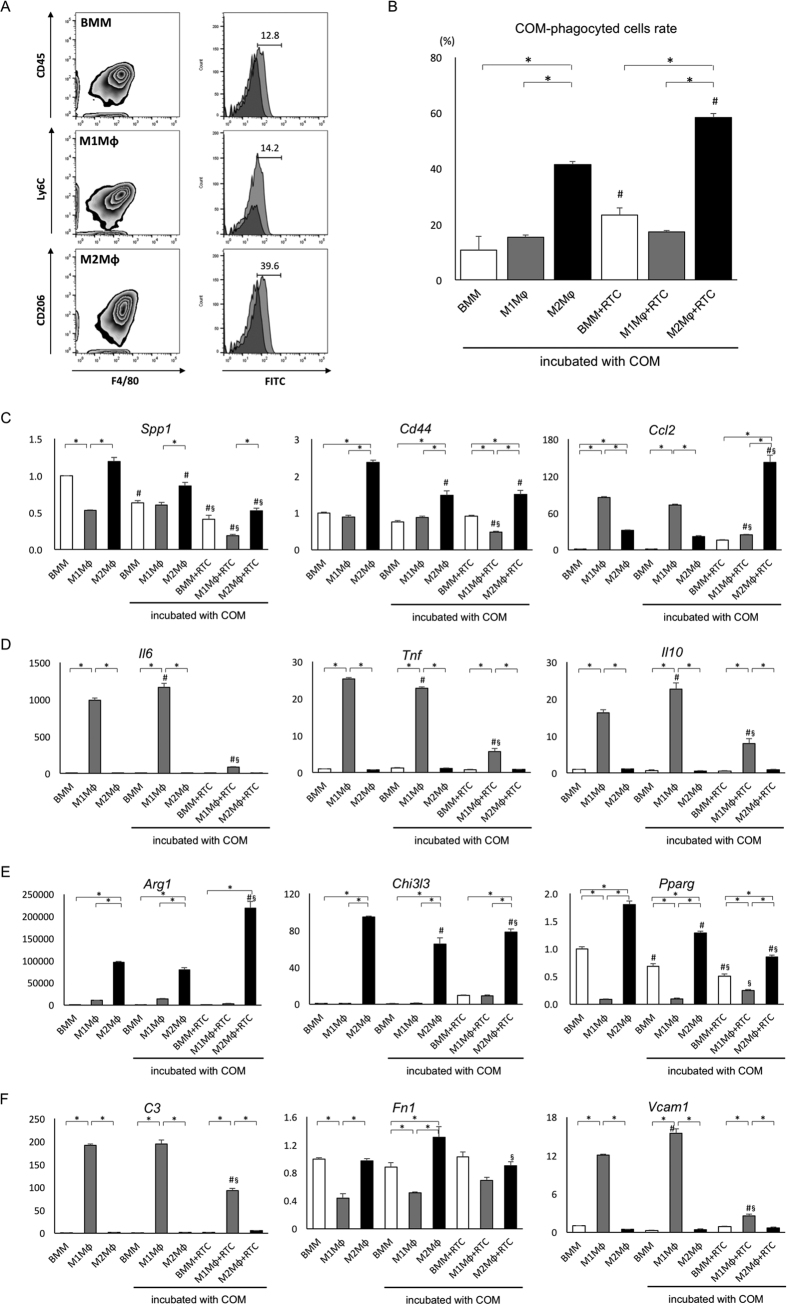
Analysis of the ability of M1 and M2 macrophages to phagocytize calcium oxalate (CaOx) monohydrate (COM) crystals in vitro.(A) Schematic representation using flow cytometry. Detection of bone marrow-derived macrophages (upper), M1 macrophages (middle), and M2 macrophages (bottom) with fluorescein isothiocyanate (FITC) -labeled COMs phagocytized by each macrophage type (right). (B) Quantitative analysis of phagocytic macrophages. The ratios of COM phagocytic macrophages were evaluated by flow cytometry. Data are presented as means ± standard errors. N = 6 for each group. *Indicates significant differences among three different macrophages at p < 0.05; #indicates significant differences in the mono-culture of each macrophage group at p < 0.05. (C) Expression of crystal-related genes. (D) Expression of M1 macrophage-related genes. (E) Expression of M2 macrophage-related genes. (F) Expression of adherence-related genes. The expression of each gene was determined by quantitative reverse transcription polymerase chain reaction (qRT-PCR) using TaqMan assays. Control values are the average of the data for bone marrow-derived Mφs (BMMs) without COM incubation group. Data are presented as means ± standard errors. N = 6 for each group. *Indicates significant differences among three different macrophages at p < 0.05; #indicates significant differences in the mono-culture of each macrophage group at p < 0.05; §indicates significant differences in the mono-culture of each macrophage group incubated with COM crystals at p < 0.05. Spp1, secreted phosphoprotein 1; Ccl2, chemokine (C-C motif) ligand 2; Il6, interleukin 6; Tnf, tumor necrosis factor; Il10, interleukin 10; Arg1, arginase 1; Chi3l3, chitinase 3-like 3; Pparg, peroxisome proliferator activated receptor gamma; Fn1, fibronectin 1; Vcam1, vascular cell adhesion molecule 1; RTC, renal tubular cell.